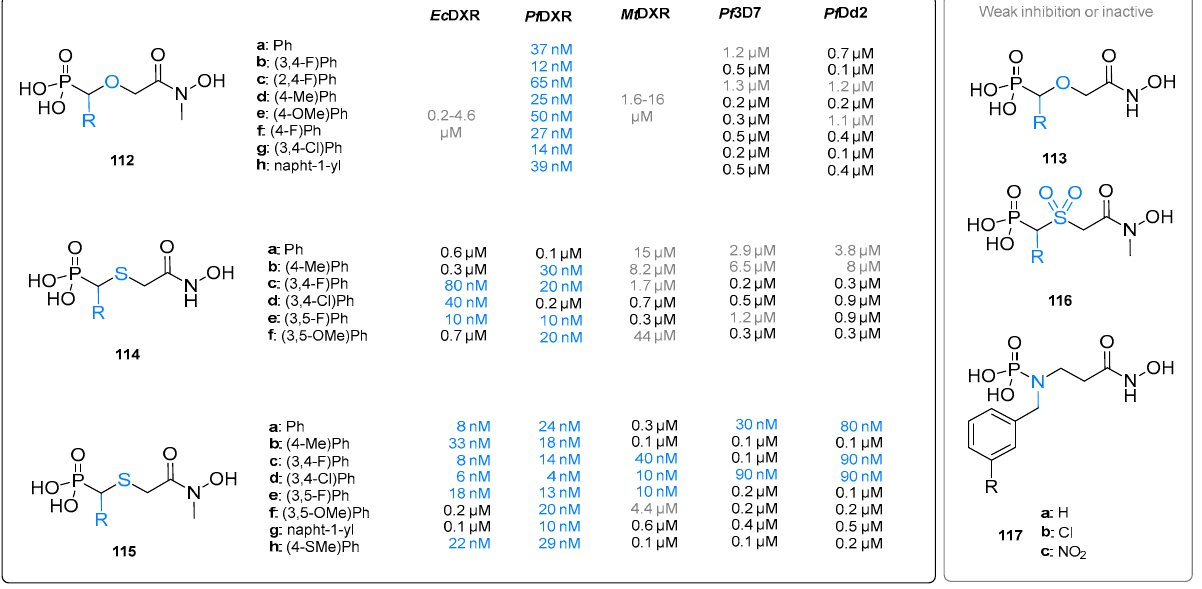
Figure 26. Antibacterial and antiplasmodial activity of thia ( 112+113 ), oxa ( 114+115 ), sulfone ( 116 ) and aza ( 117 ) analogs.